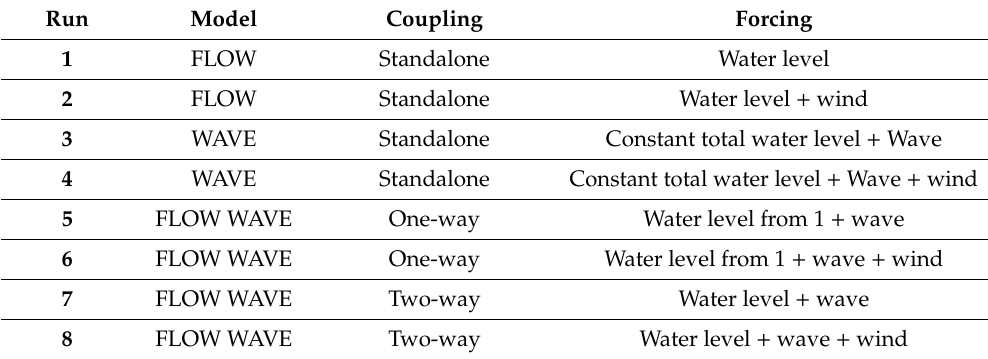
Table 1. Eight model simulations completed in Delft3D for each historic storm event, and outputs used to force the boundary of the Oldbury model domain in LISFLOOD-FP from the low water mark and defence crest. Run 8 has been successfully validated to tide gauges and wave buoys throughout the model domain and is used as the baseline